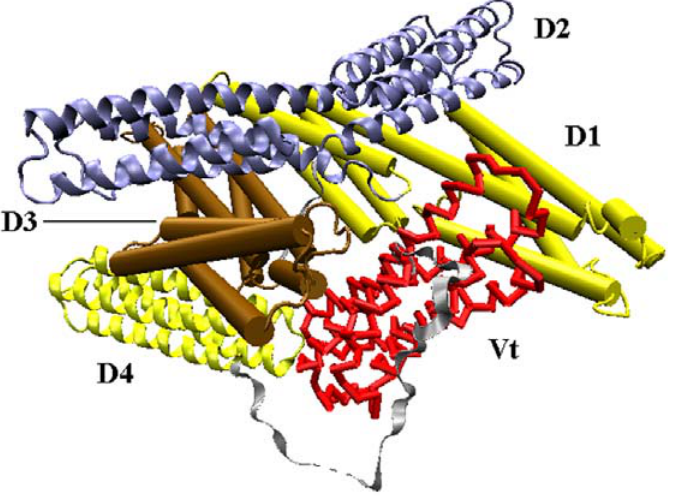
Figure 1. The front view of vinculin (PDB ID: 1TR2). D1 and D3 domain is drawn in cartoon mode, and the D2 and D4 domain is in ribbon mode. The Vt domain is drawn with trace method. D1, D2, D3, and D4 form the head of the protein, and Vt is the